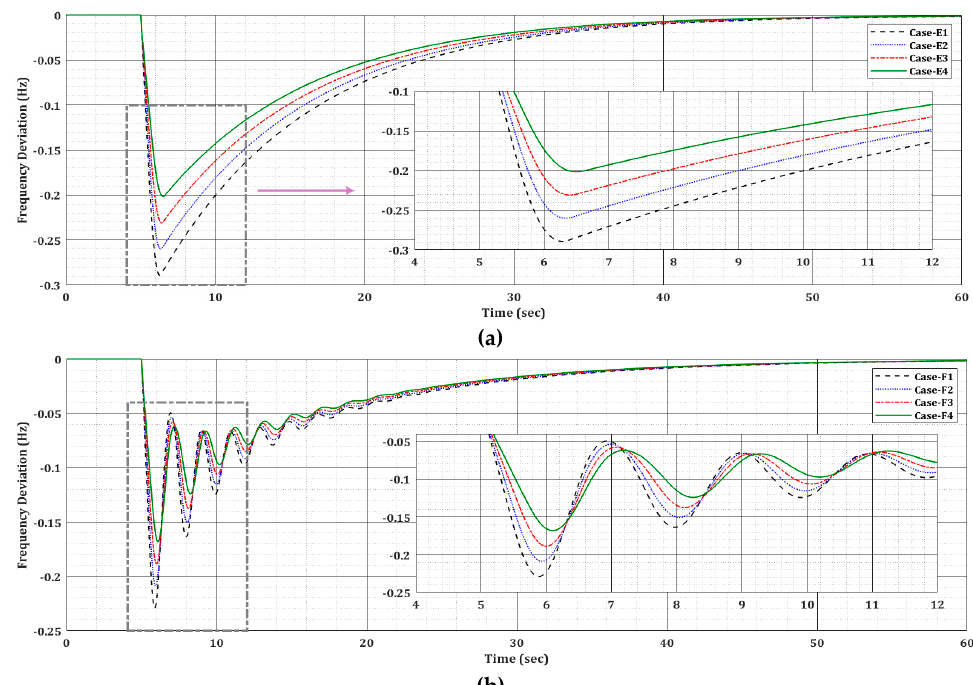
Figure 7. Frequency response under load disturbance when the test system is equipped with ESS ( a ) frequency deviation for test cases (E1-E4); ( b ) frequency deviation for test cases